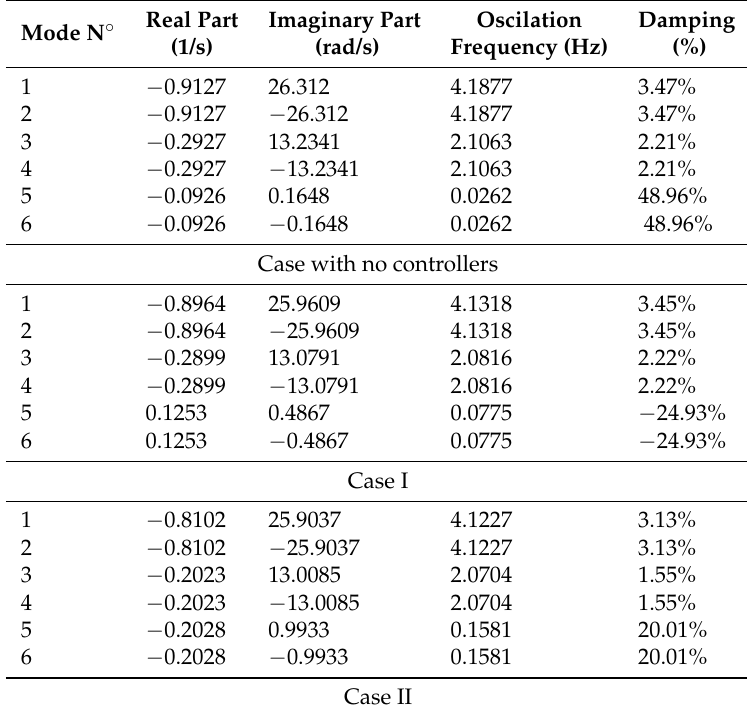
Table 9. Eigen values system